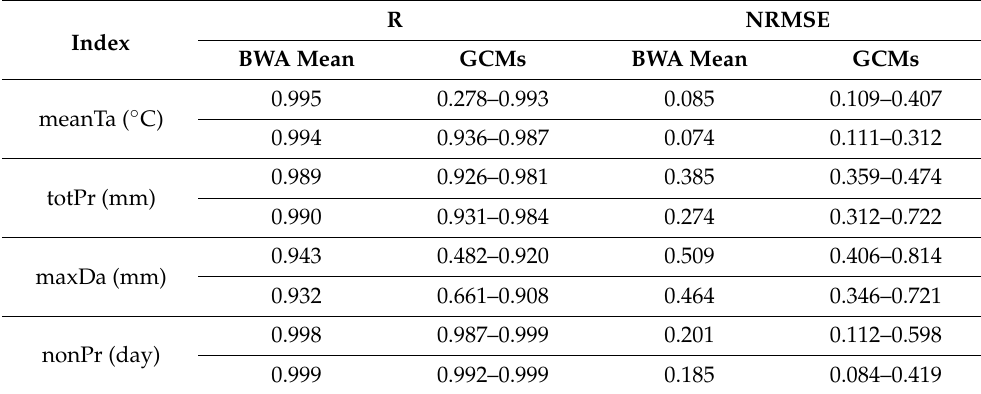
Table 2. The values of coefficient of correlation (R) and normalized root mean square error (NRMSE) for BWA means and individual GCMs for 4 indices for CMIP5 (the first row in each index) and for CMIP6 (the second row in each index).